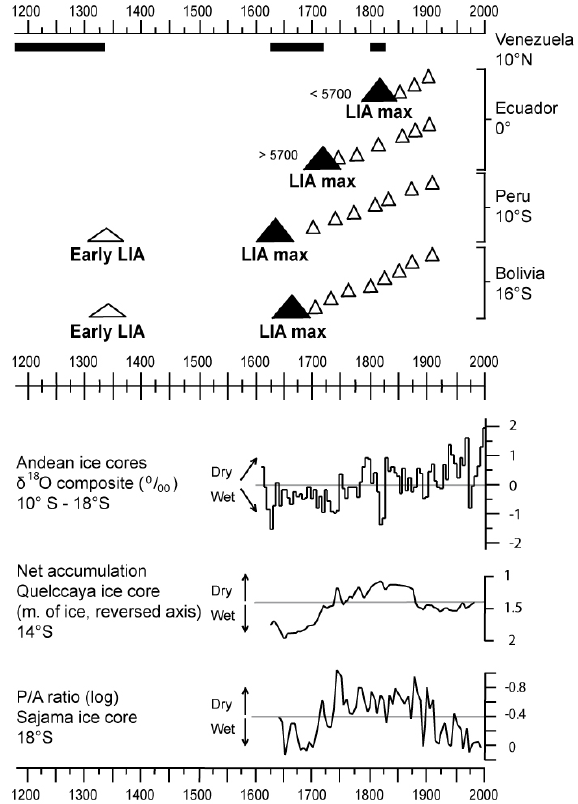
Fig. 2. Upper panel: comparison of moraine stages (triangles) dated by lichenometry (Bolivia, Peru, Ecuador) and periods of glacier advances (horizontal black bars) evidenced from lake sediments (Venezuela). For each country, the triangles qualitatively represent the position of the moraines along a schematic proglacial margin, from the lowest one representing the period of maximum extent of the LIA (the black triangle), to the uppermost moraine stage, clos- est to the current glacier snout. For Ecuador, two schemes are rep- resented, one for proglacial margins of glaciers with a maximum elevation higher than 5700ma.s.l., and one for glaciers with a max- imum elevation below 5700ma.s.l. Lower panel: proxies of climate variations (wet/dry periods) in recent centuries. The P/A ratio in the Sajama ice core (Liu et al., 2005) represents the relative change in abundance of two pollen species (Poaceae and Asteraceae) and is used as a proxy of moisture on the Altiplano. Data from ice cores come from Thompson et al. (1985,